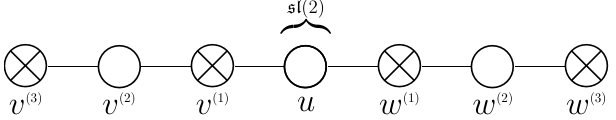
and w ( a ) are in j j and ~ w ( a ) . The roots v (1) j j j